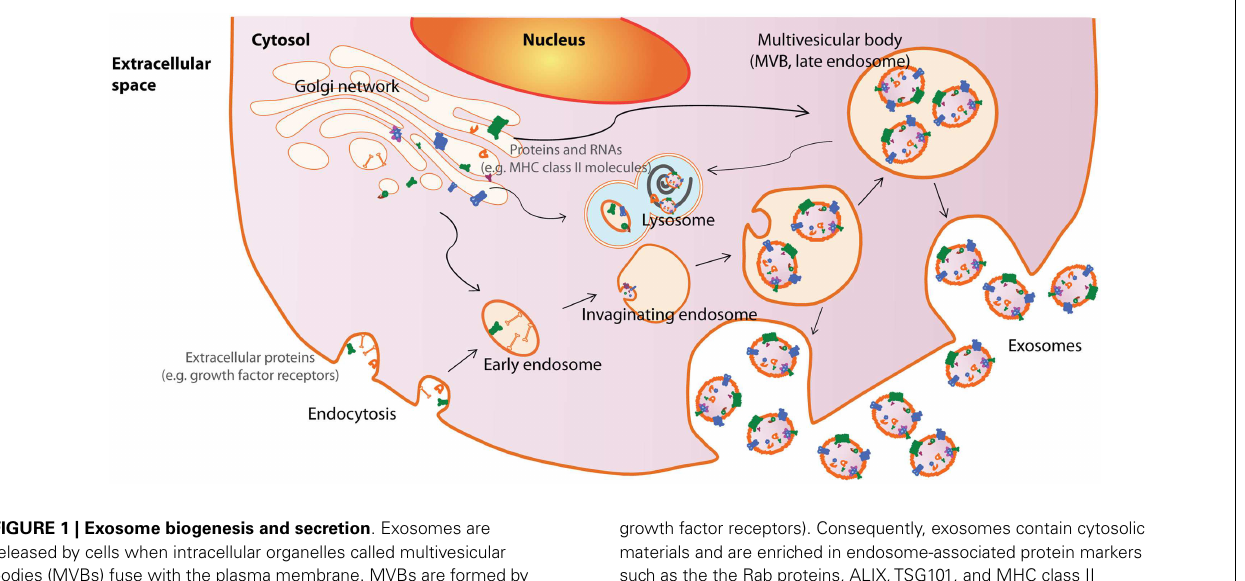
FIGURE 1 | Exosome biogenesis and secretion . Exosomes are released by cells when intracellular organelles called multivesicular bodies (MVBs) fuse with the plasma membrane. MVBs are formed by invaginations of late endosomes, which contained molecules from the Golgi (e.g., MHC class II molecules) or the cell surface